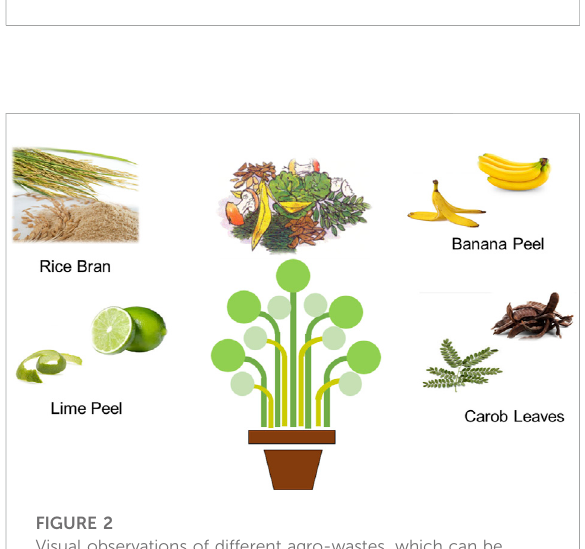
FIGURE 1 The steps involved in the production of iron oxide nanoparticles (IONP).